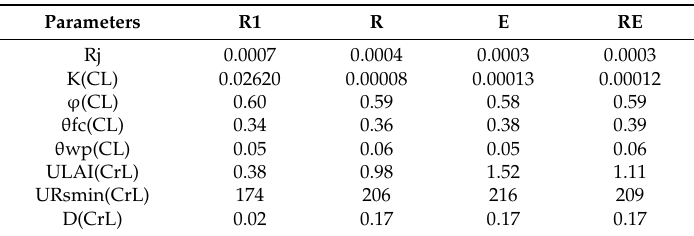
Table 3. Specific values of eight calibrated parameters for trade-off solutions from single and multi-objective calibration (R1, R, E,